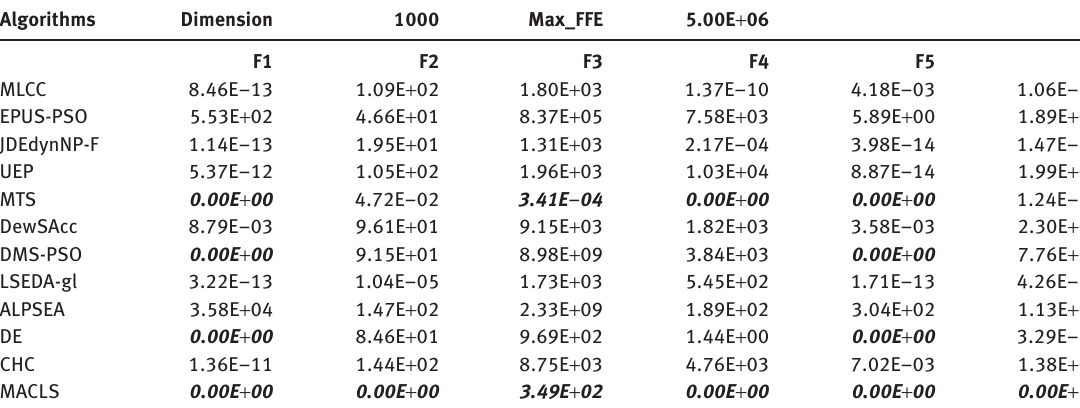
Table 8: Mean Error Values Achieved for Problems F1–F6, with D = 1000.